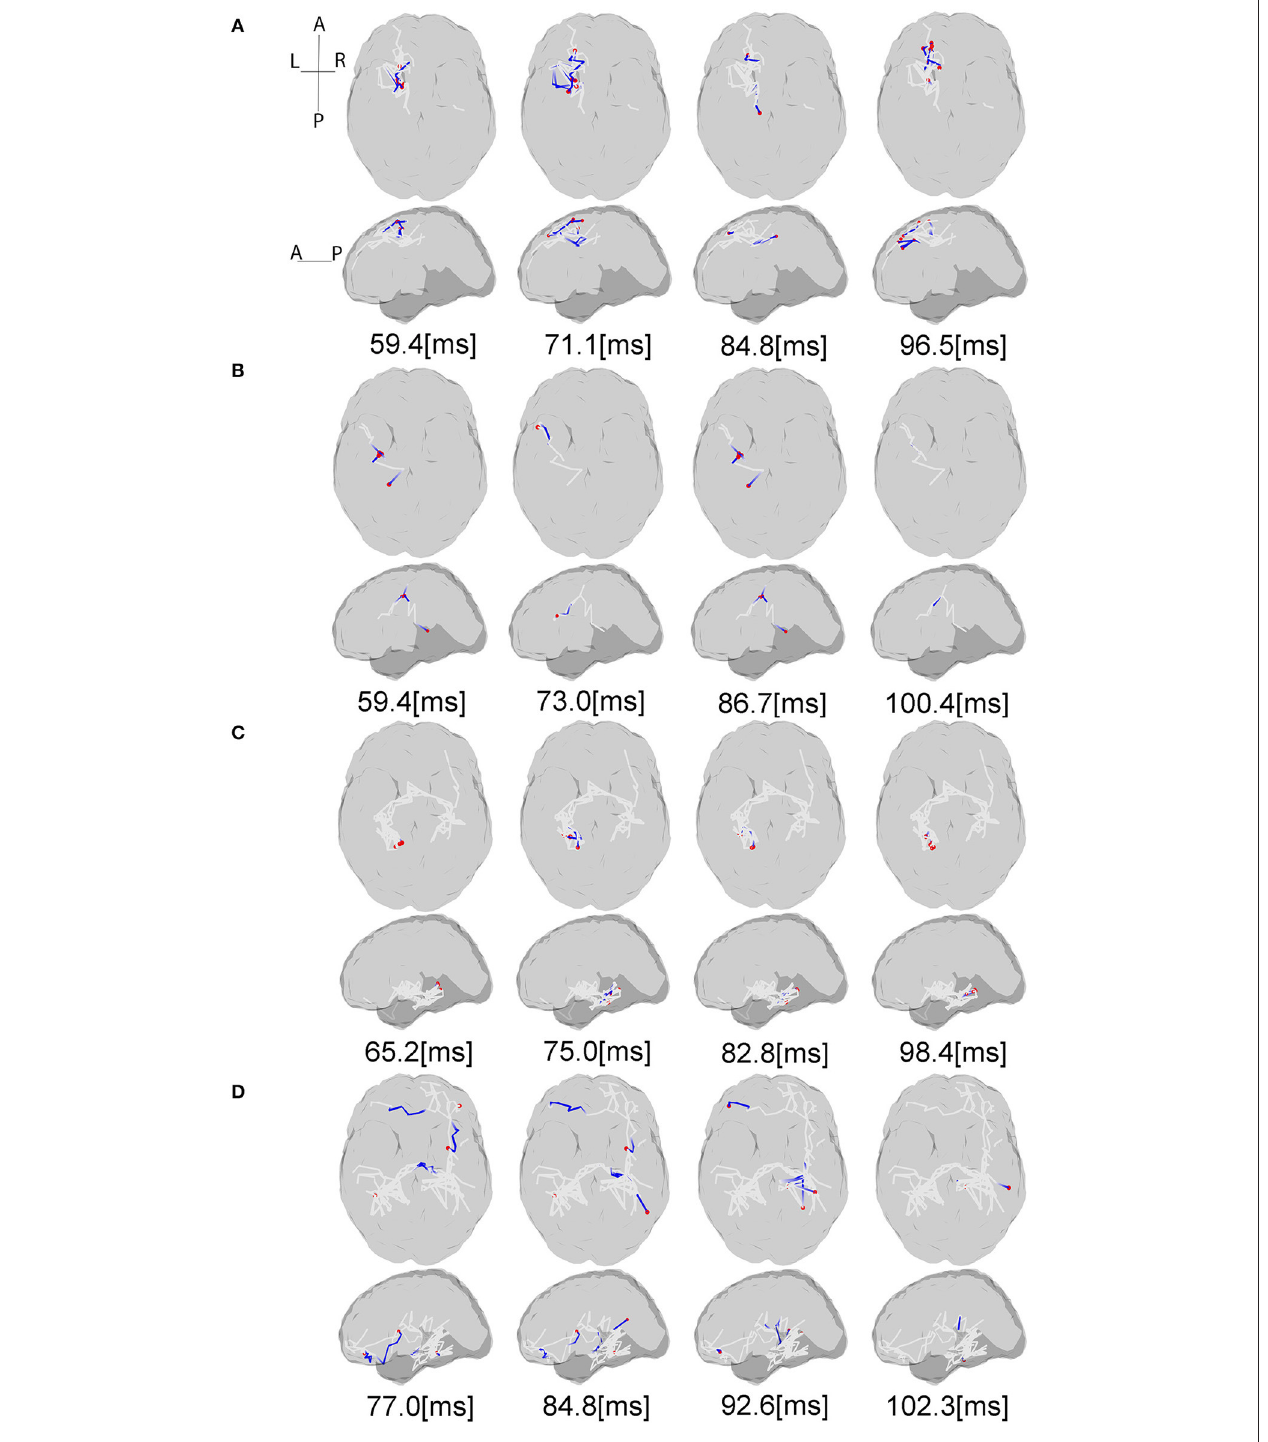
FIGURE 5 | Source interactions estimated from LCD model. The plots show the information flow between P50 and N100 for each subject and anatomic connections between the active sources estimated via white matter tractography based on the individual dMRI acquisitions. The gray lines indicate the whole fiber network involved in the transmission of somatosensory information flow through the brain. The blue lines show the currently active fibers, and red dots are the currently active sources on the cortex at the specific time points. The “active sources” here denotes the sources have electrical neural activities at the presented time point, while “active fibers” indicate the fibers where the information flow is traveling through. For each subject projection of all axial slices (top) and of all sagittal slices (bottom) are shown. (A,B) Controls, (C) stroke 1, (D) stroke 2. For the full visualization see Supplementary Material .